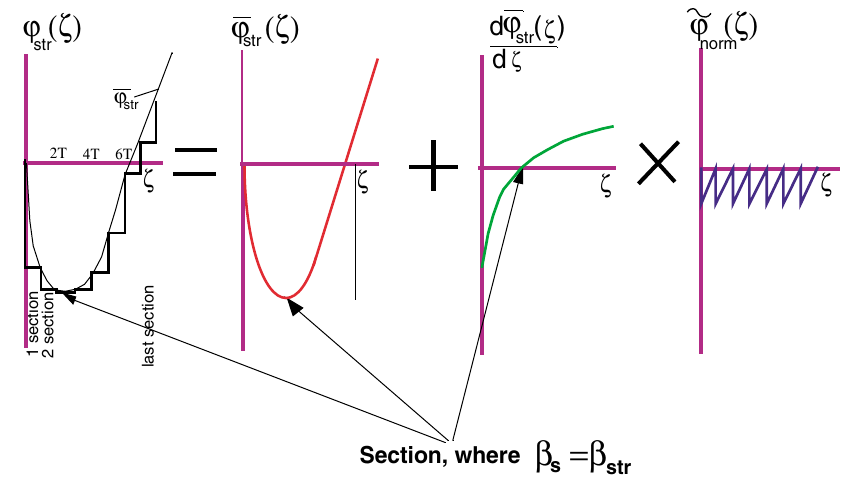
FIG. 4. (Color) Intersection rf phasing in